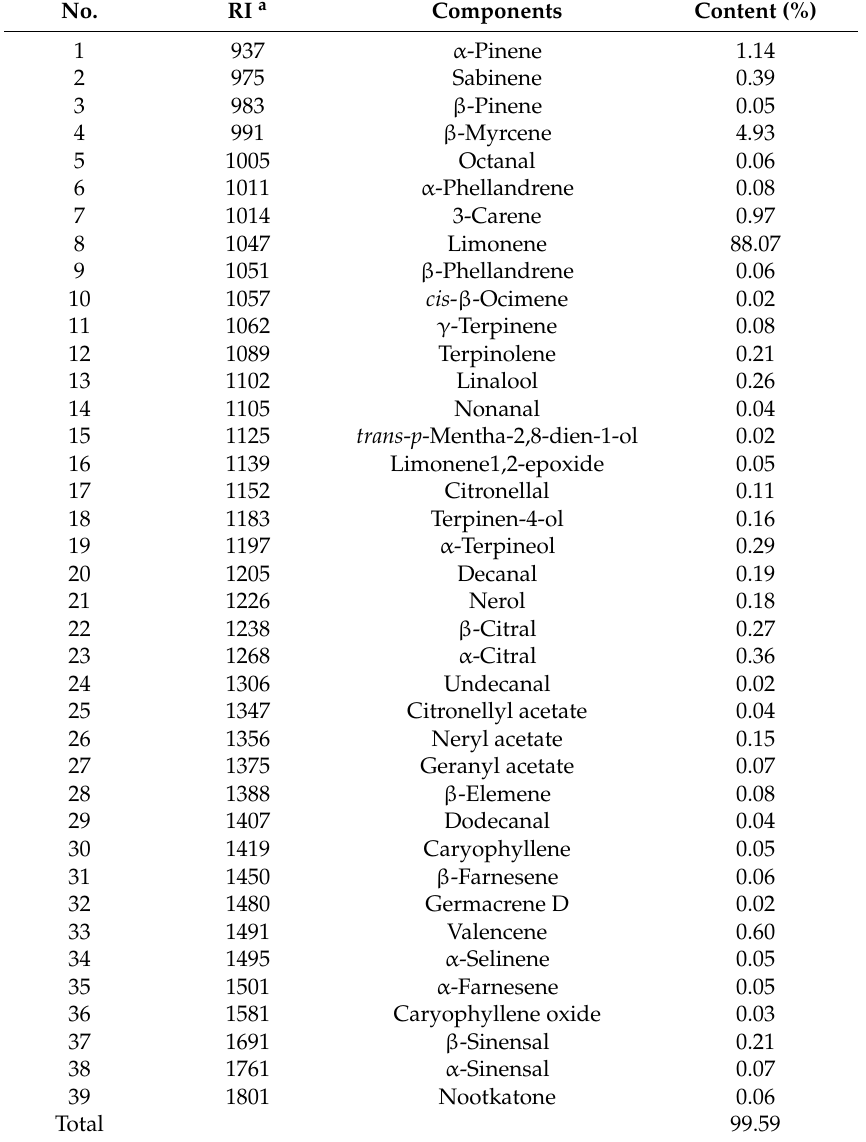
Table 3. Chemical composition of